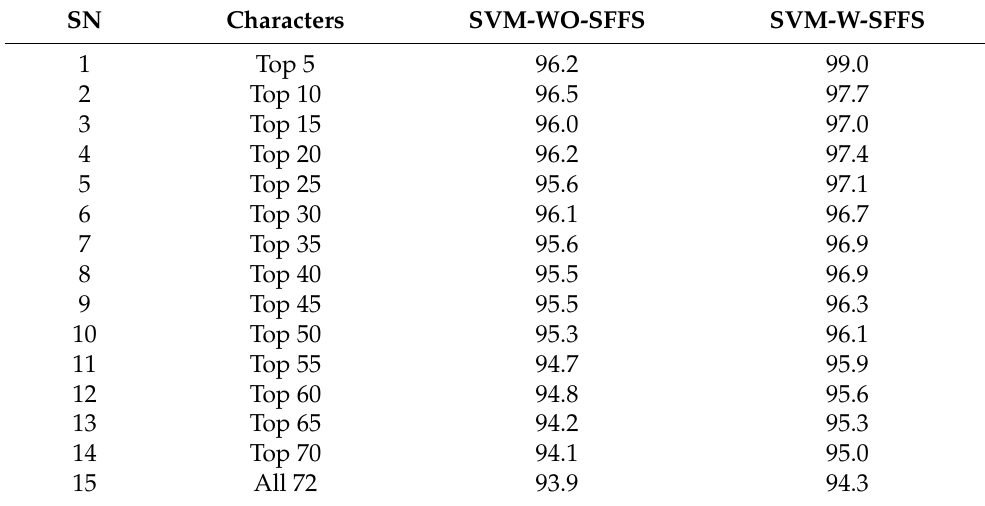
Table 6. Identification accuracy (in %) of Kanji characters used for each of the five letters.